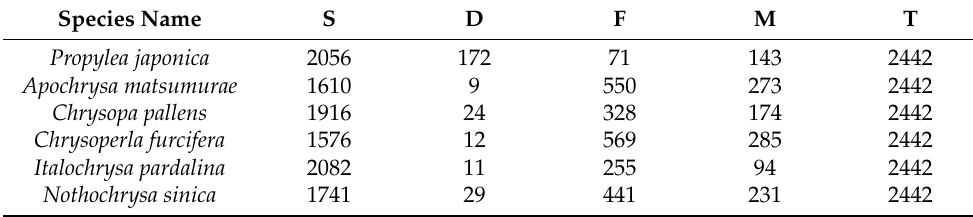
Table 3. Summary of BUSCO results of species used in this study.